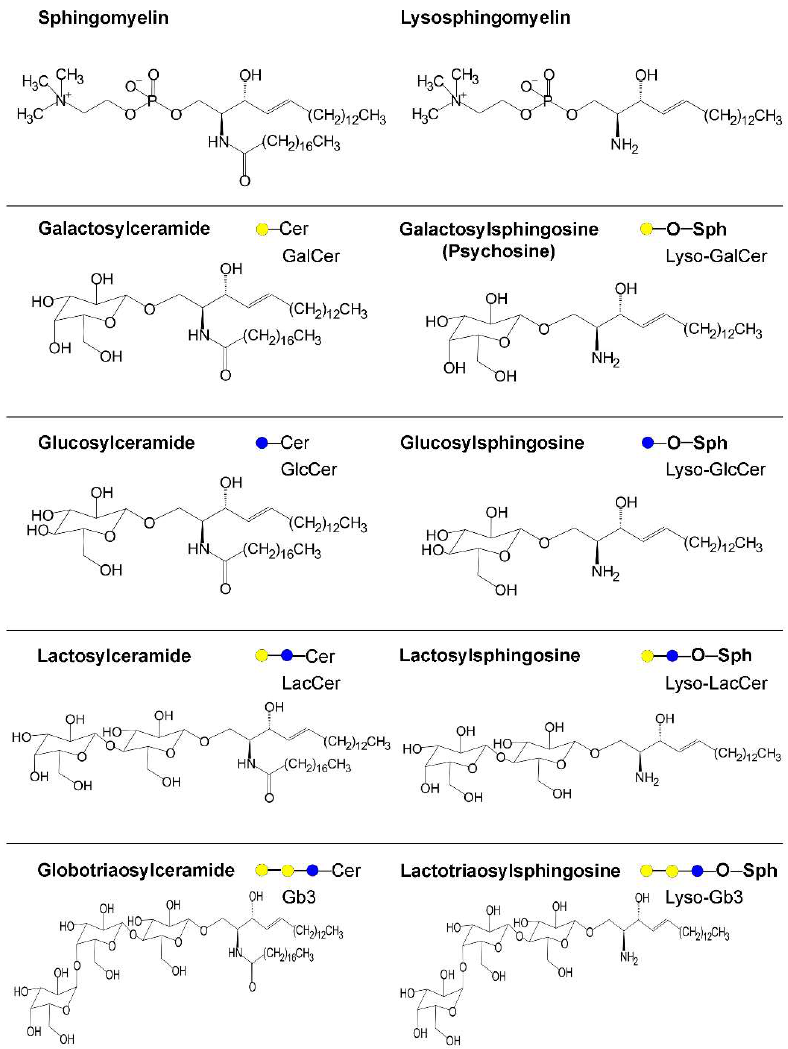
Figure 3. Structure of lysosphingolipids and related compounds. Lysosphingolipds are complex sphingolipids deacylated by the action of acid ceramidase on the corresponding compounds accumulated because of an inborn error of metabolism. Sph, sphingosine. For simplicity, only stearic acid is depicted as the acyl chain, but longer fatty acids are also frequently